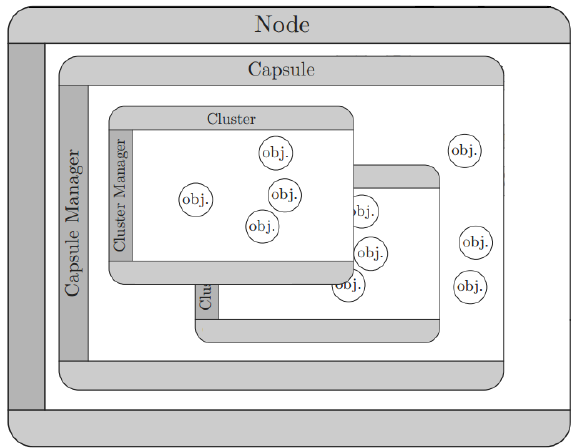
Figure 6. Representation of the objects part of the Engineering viewpoint and its hierarchical structure. Source: